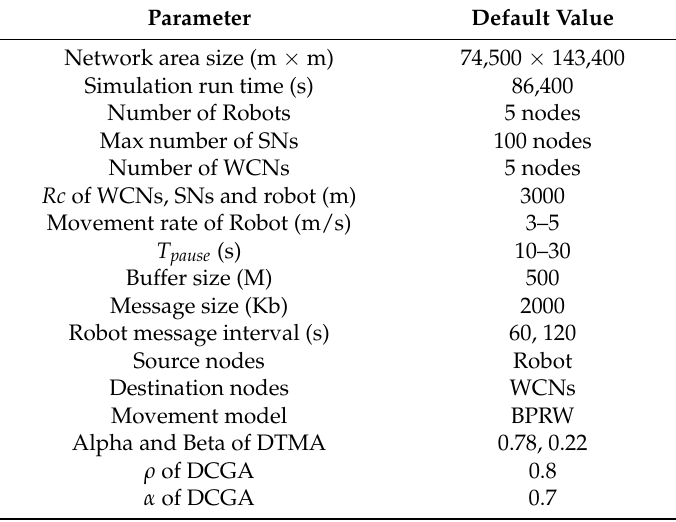
Table 1. Default parameters of the